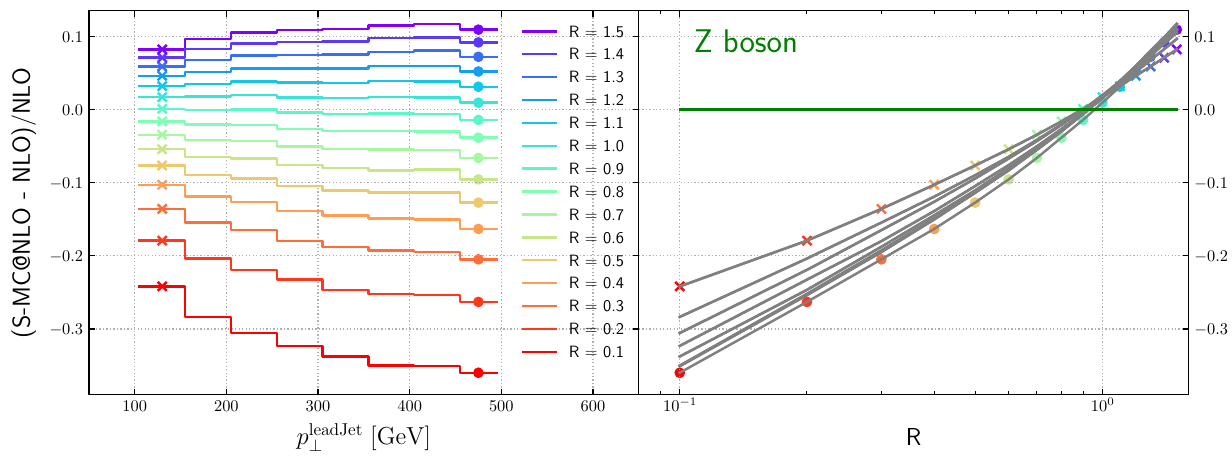
Fig. 14 Relative difference between the NLO-matched prediction and the fixed-order result as a function of the leading jet transverse momentum and the jet radius, for H + ≥ 1 jet